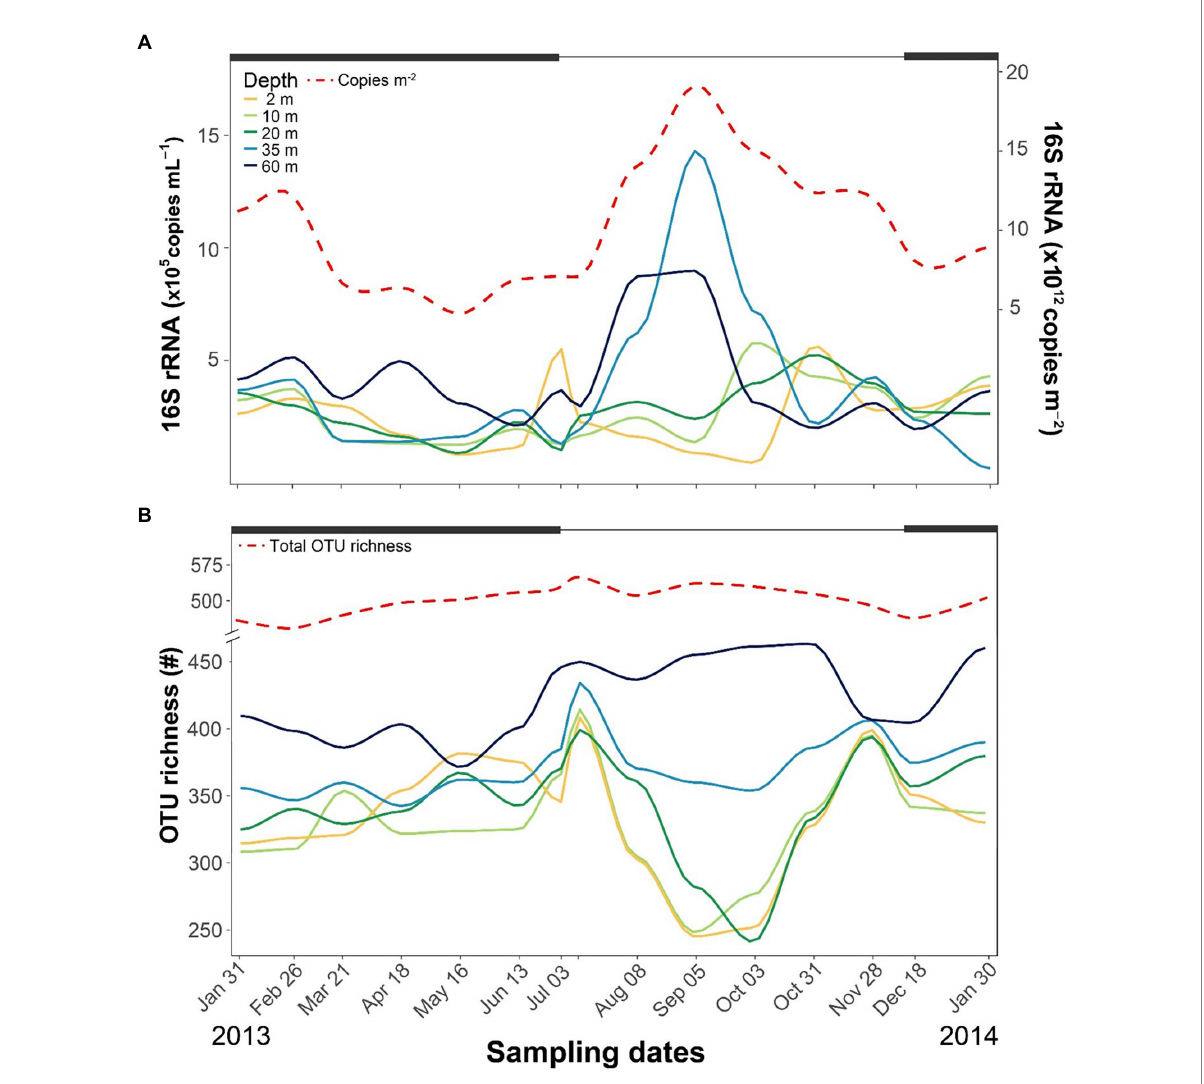
FIGURE 2 Seasonal fluctuations of bacterioplankton number of 16S rRNA gene copies (A) and OTU richness (B) at different depths. Thick black lines at the top of each graph indicate periods of ice